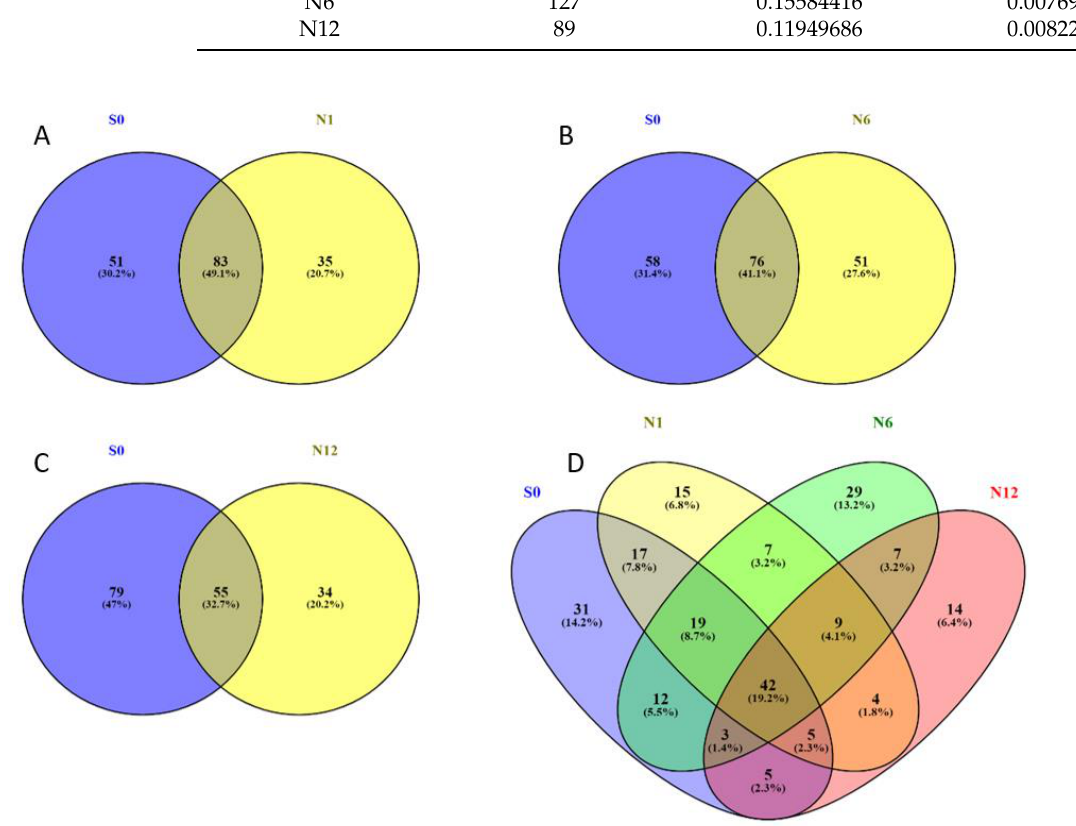
Figure 2. Relative quantitative shared and unique proteins captured by Bis-probe in S0, N1, N6 and N12 samples. Presented as a 2-way Venn diagram in ( A – C ) and a 4-way Venn diagram in ( D ).